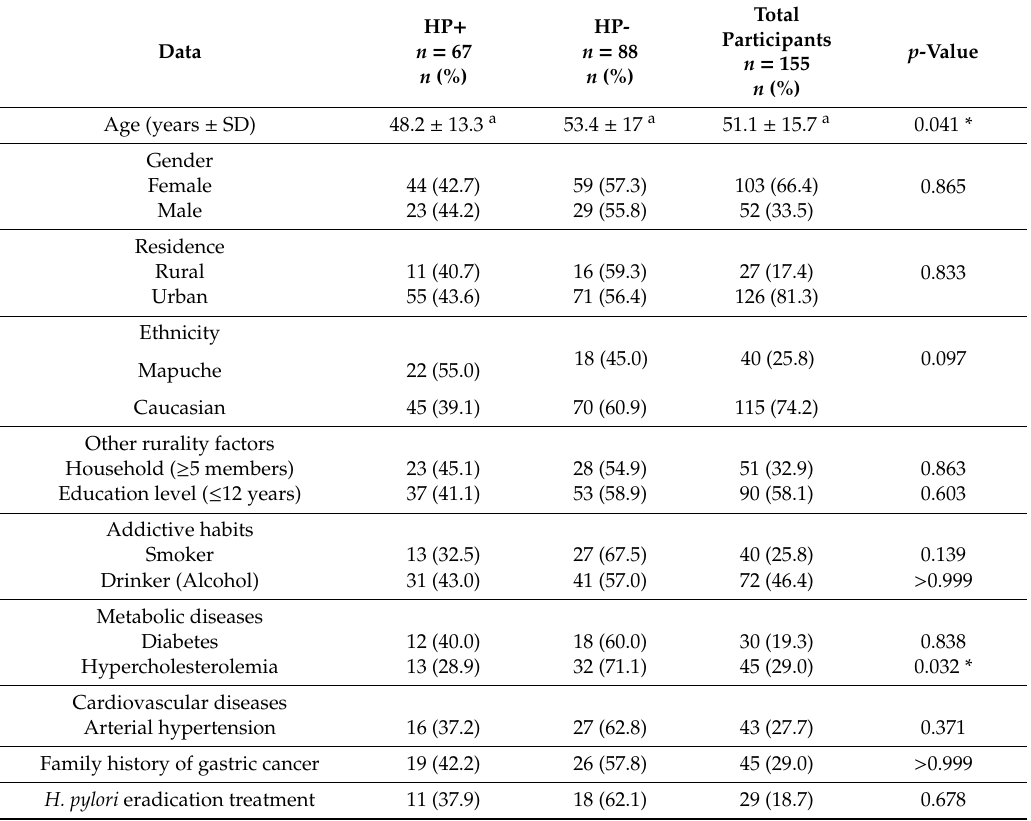
Table 1. Characteristics of participants according to the Helicobacter pylori